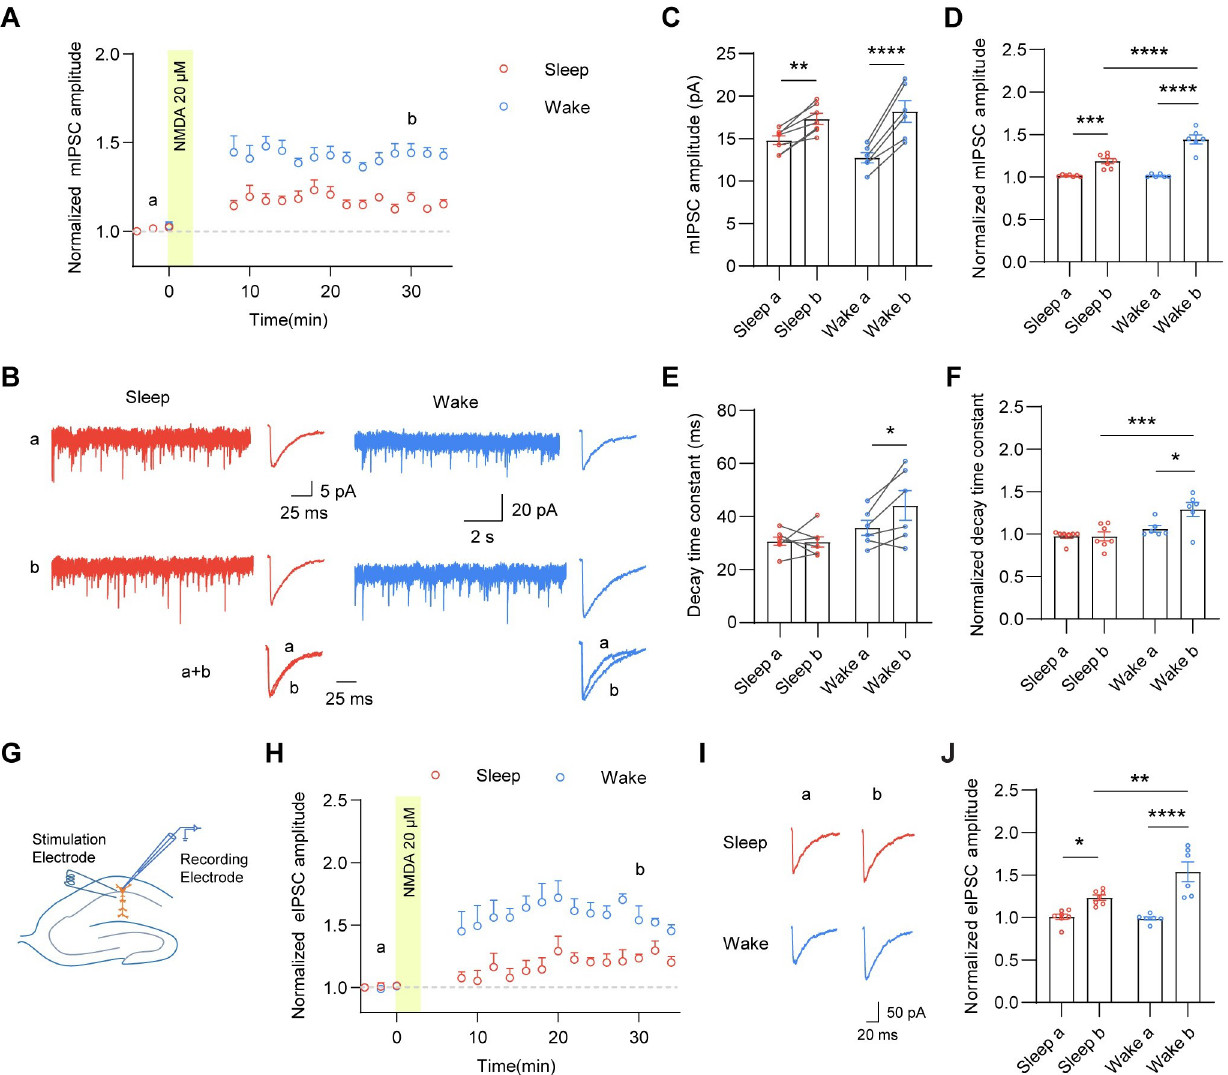
Fig 2. Enhancement of iLTP by the wakefulness. (A) Brief NMDA exposure (3 min, 20 μ M) to hippocampal slices was sufficient to induce a persistent increase in mIPSC amplitude over an approximately 30-min period in sleep and wake mice. The data were binned into 2-min time bins. (B) Representative mIPSC traces and average mIPSC traces at indicated time points in (A) from the CA1 pyramidal neuron in acute hippocampal slices prepared from sleep and wake mice. a+b indicated peak-scaled overlays showing the difference of decay time constants between time points a and b. (C) NMDA application induced a persistent increase in mIPSC amplitude in CA1 pyramidal neurons in wake and sleep mice ( n = 6–7, 2-way ANOVA, F (1, 11) = 89.98, p < 0.0001 with Sidak’s multiple comparison test, Sleep a versus Sleep b, p = 0.0021; Wake a versus Wake b, p < 0.0001). (D) mIPSC amplitude in CA1 pyramidal neurons in wake mice 30 min post-NMDA application had a higher potentiation than sleep mice ( n = 6–7, 2-way ANOVA, F (1, 22) = 19.11, p = 0.0002 with Sidak’s multiple comparison test, Sleep a versus Sleep b, p = 0.0004; Wake a versus Wake b, p < 0.0001; Sleep b versus Wake b, p < 0.0001). (E, F) NMDA application enhanced mIPSC decay time constant in wake mice but not sleep mice (E: n = 6–7, 2-way ANOVA, F (1, 22) = 4.572, p = 0.043 with Sidak’s multiple comparison test, Sleep b versus Wake b, p = 0.014. F: n = 6–7, 2-way ANOVA, F (1, 22) = 4.918, p = 0.0372 with Sidak’s multiple comparison test, Sleep b versus Wake b, p = 0.014; Wake a versus Wake b, p = 0.0006). (G) IPSCs evoked by electrical stimulation (eIPSCs) in perisomatic region. (H) Time course of eIPSC amplitude before and after NMDA application. (I) Representative eIPSC traces at indicated time point in (H) from CA1 pyramidal neurons in acute hippocampal slices prepared from sleep and wake mice. (J) eIPSC amplitude in CA1 pyramidal neurons in wake mice 30 min post-NMDA application had a higher potentiation than sleep mice ( n = 6–7, 2-way ANOVA, F (1, 22) = 7.403, p = 0.0125 with Sidak’s multiple comparison test, Sleep a versus Sleep b, p = 0.02; Wake a versus Wake b, p < 0.0001; Sleep b versus Wake b, p = 0.003). The data underlying this figure can be found in S1 Data. � p < 0.05, �� p < 0.01, ��� p < 0.001, and ���� p < 0.0001. All data are presented as mean ± SEM. iLTP, inhibitory long-term potentiation; mIPSC, miniature inhibitory postsynaptic